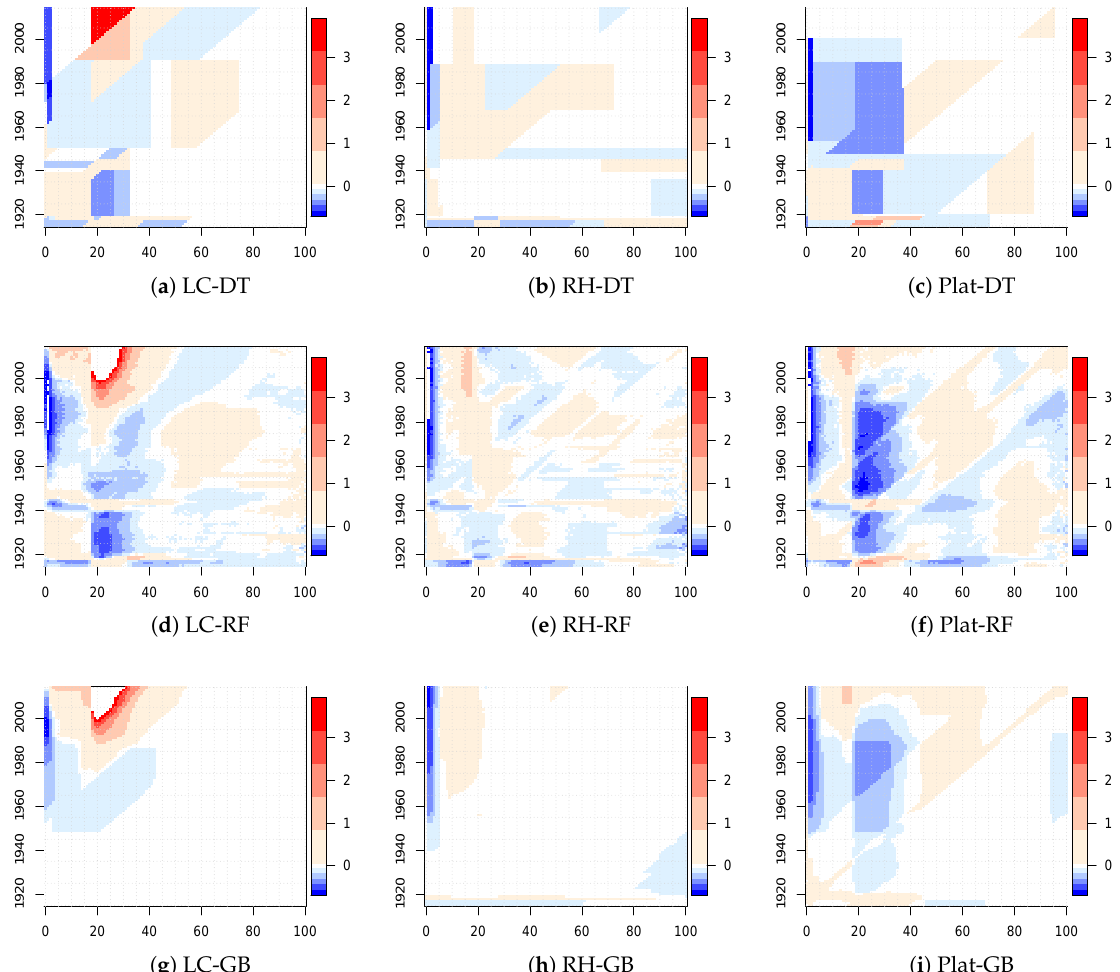
Figure 3. Values of ∆ m mdl,ML x . Italian male population. Ages 0–100 and years